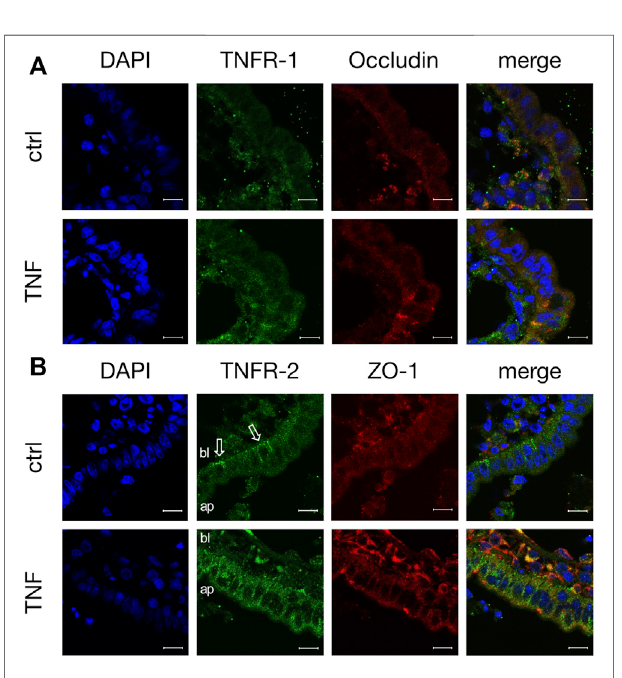
FIGURE 8 | Immunohistological staining of speci fi c TNF receptors (A) TNFR-1 (green) and occludin (red) after 10 h incubation of tissue with or withoutTNF (B) TNFR-2(green)andZO-1(red)werestainedforconfocallaser scanning immuno fl uorescence microscopy. For better orientation, the basolateral side of FAE is labelled “ bl ” , and the apical part “ ap ” . White arrows indicatethebasolateralsignalforTNFR-2incontroltissues.DAPIwasusedfor the staining of cell nuclei (scale bar: 40 μ m, n = 3, representative images).